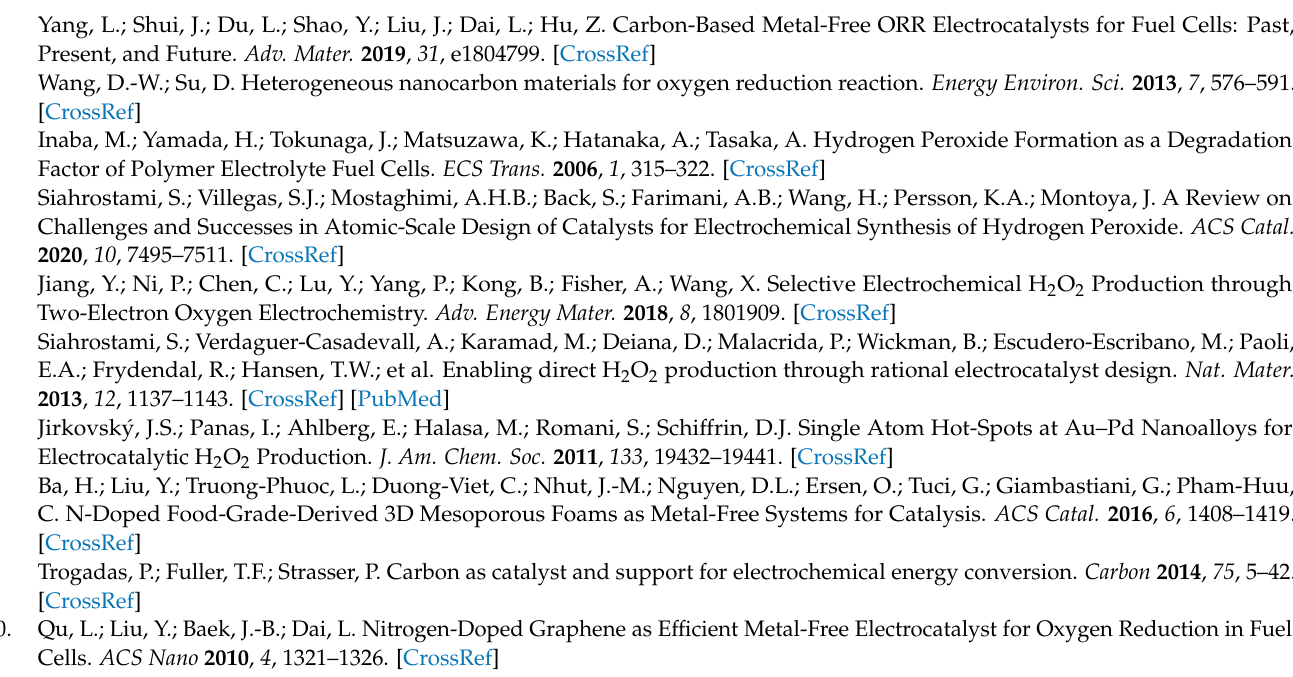
Figure S8; ORR electrochemical results for GA-CNT-FeN_600 CNT using RDE; Figure S9. ORR electrochemical results for GA-CNT-FeN_700 CNT using RDE. Figure S10: ORR electrochemical results for GA-CNT-FeN_800 CNT using RDE; Figure S11: ORR electrochemical results for Pt 20%- Vulcan using RDE; Figure S12: Photography of hydrogel after hydrothermal synthesis in the absence of Fe phenanthroline and in the presence of Fe phenanthroline; Figure S13. XRD of the composites with Fe; Figure S14: XPS spectra of Fe 2p and 1 deconvolution of the N1s XPS core level spectra; Figure S15: Scheme of the preparation of the different electrocatalysts. Table S1: parameters of LSV curves of graphene aerogel-CNT hybrid doped with nitrogen and